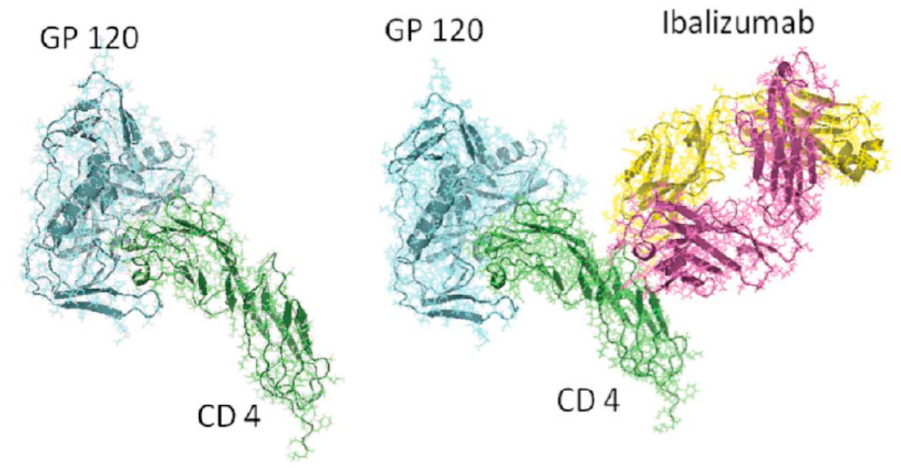
Figure 5. Ibalizumab. Figure 5.